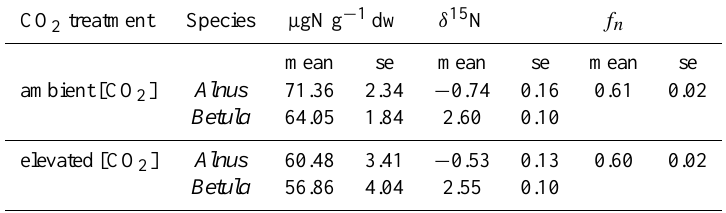
Table 3. N concentration and δ 15 N of Alnus and Betula leaves and the fraction of N in Alnus taken up through N 2 -fixation ( f n ) .